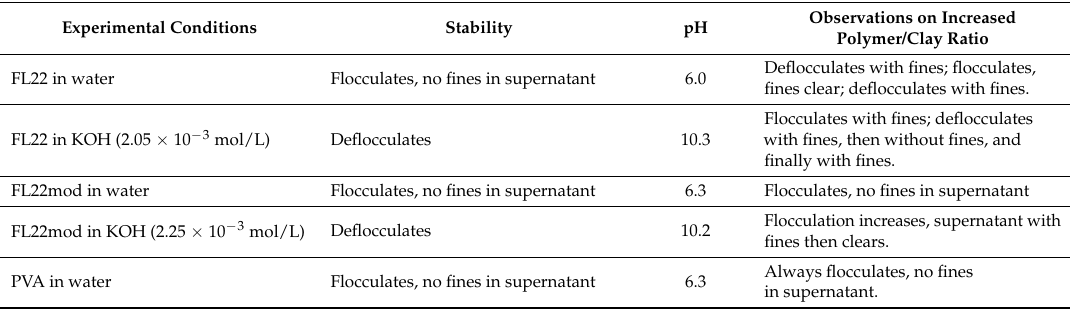
Table 3. Description of the changes observed on increasing the polymer/clay ratio during flocculation experiments. Fines = fine particles in supernatant